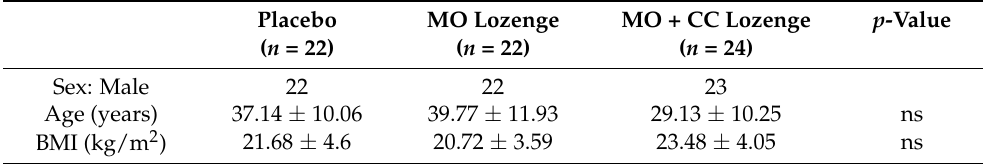
Table 3. The characteristics data of subjects in placebo, MO lozenge, and MO + CC lozenges groups. The different of age and body mass index (BMI) among three groups were analyzed by one-way ANOVA at the p < 0.05 level. The values are the mean ± SD, ns is not significant. MO: Moringa oleifera ; CC: Cyanthillium cinereum.